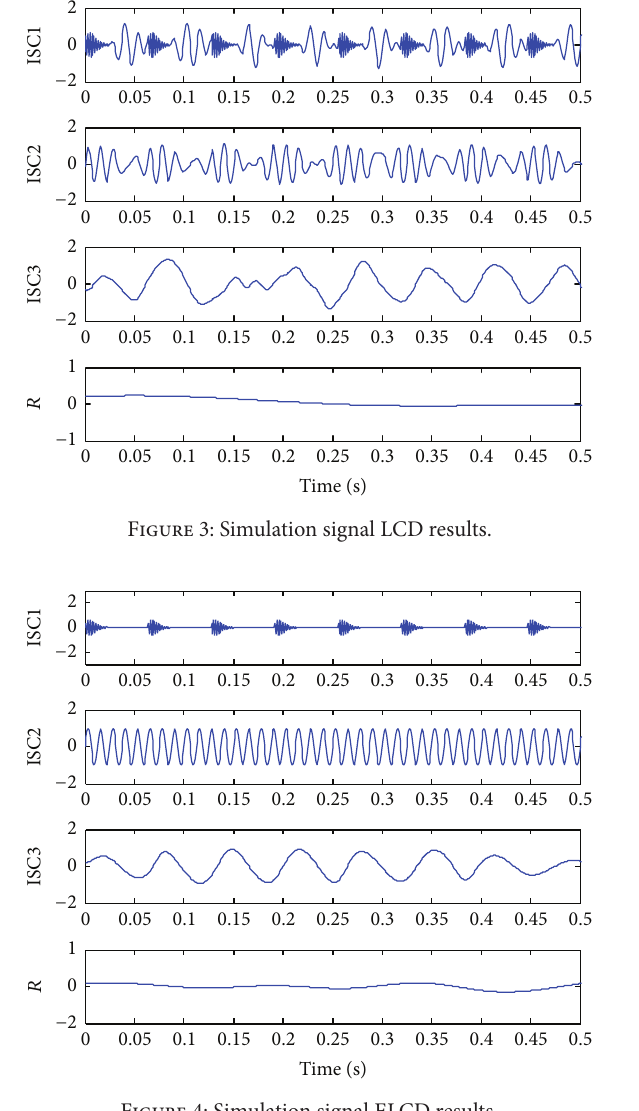
Figure 4: Simulation signal ELCD